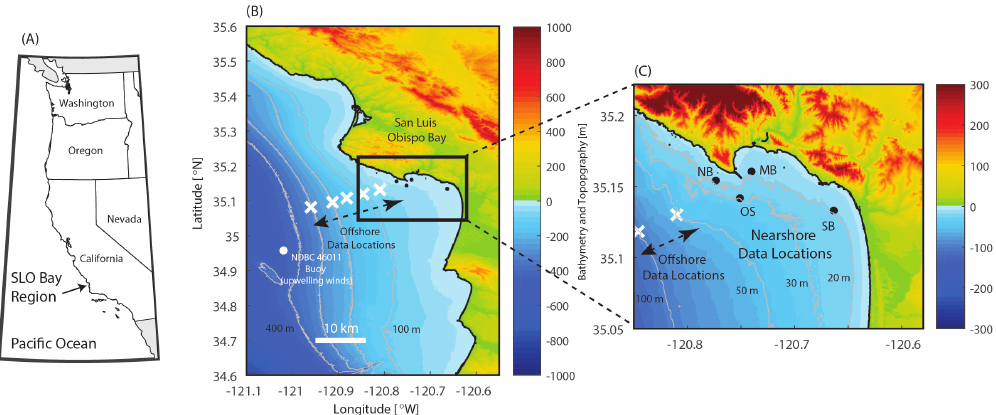
Figure 1. ( A ) United States West Coast showing the San Luis Obispo (SLO) Bay region located along the Central California Coast. ( B ) Regional view showing the location of the offshore hydrographic transects (white X), the regional buoy used for the upwelling wind stress, and isobaths from 100 m to 400 m (gray lines). ( C ) Local view of SLO Bay highlighting the four mooring locations (black dots) and isobaths at 20, 30, 50, and 100 m (gray